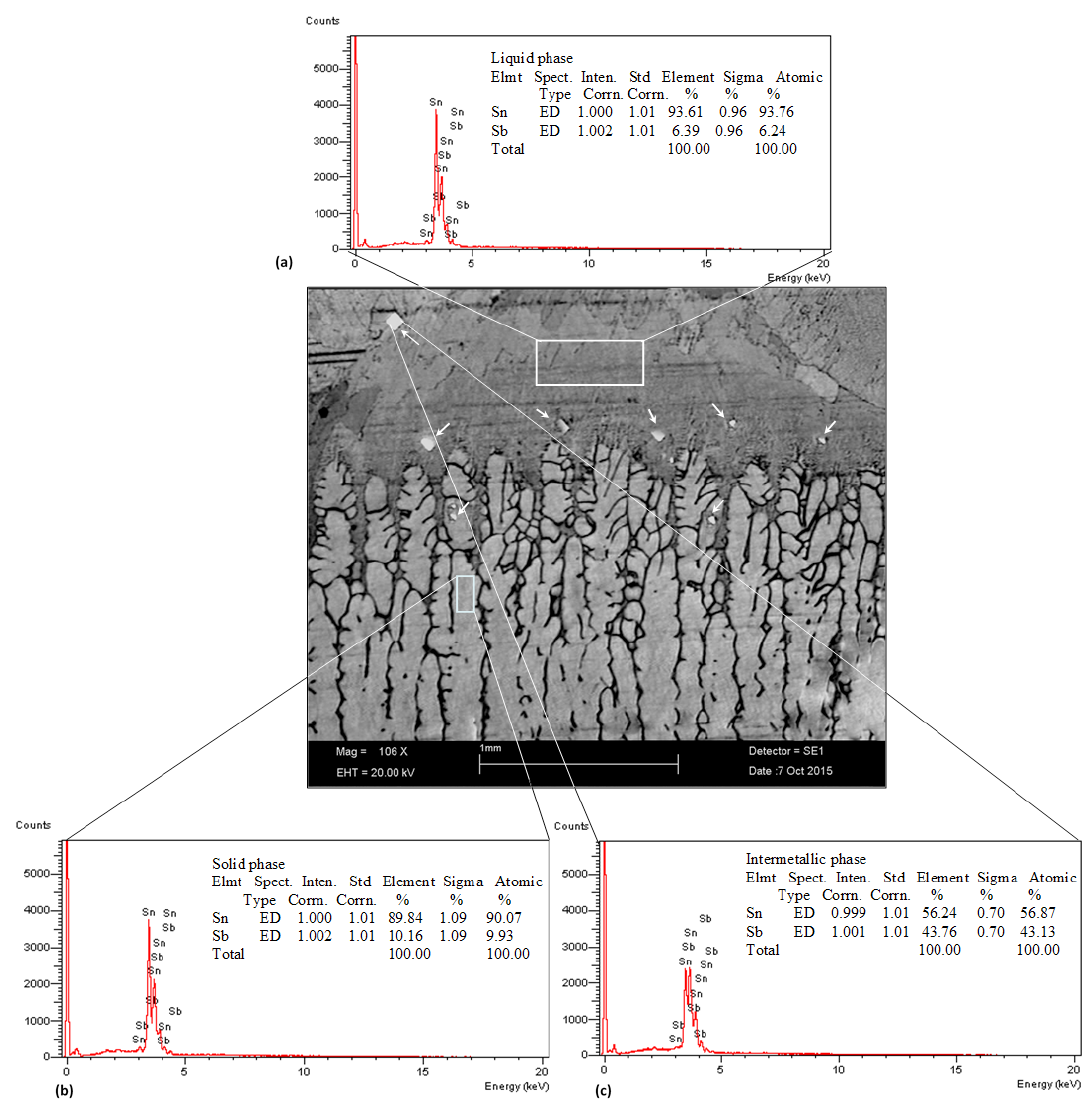
Figure 3. The chemical composition analysis of the Sn–10.2 Sb peritectic alloy (a) Dark gray phase (Sn-rich quenched liquid phase) (b) Light gray phase (β–Sn phase) (c) White phase (indicated by arrows) SnSb intermetallic